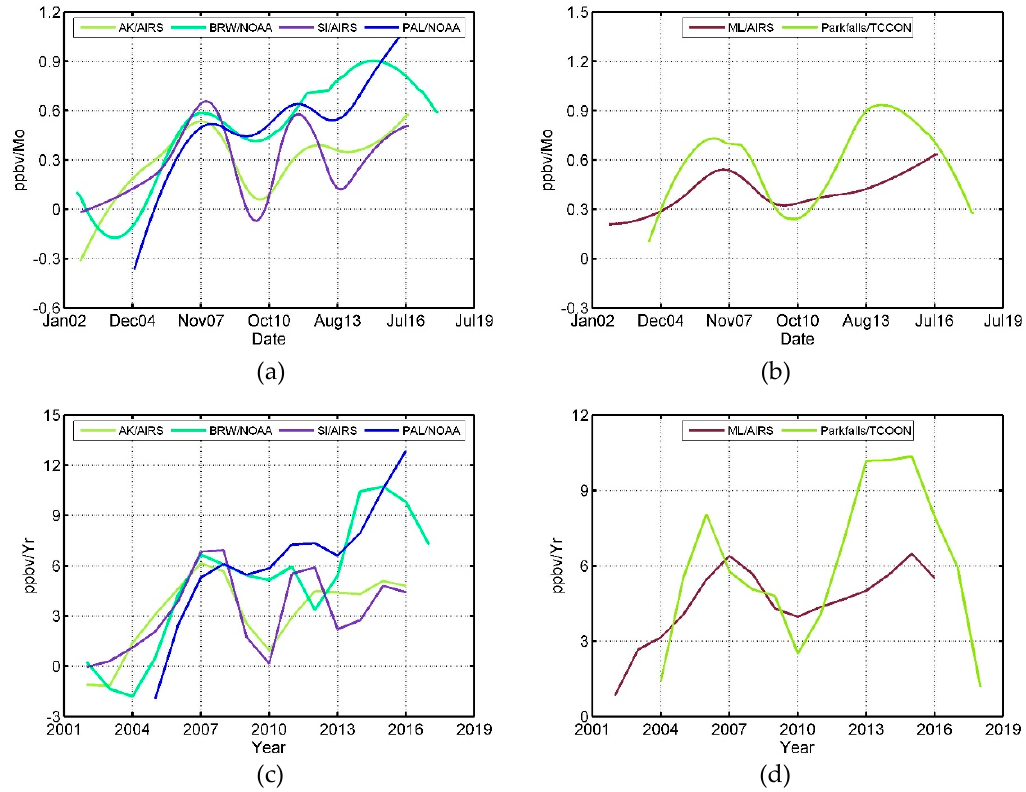
Figure 5. Comparisons of monthly and annual CH 4 increase rates (ppbv per month, ppbv/Mo and ppbv per year, ppbv/Yr) in the Northern Hemisphere from AIRS, TCCON, and NOAA ground-based measurements. ( a ), ( c ) show monthly and annual AIRS CH4 increase rates at 400 hPa over Alaska and Siberia regions and also surface CH 4 increase rates from two NOAA ground stations located in these two regions, respectively; ( b ), ( d ) show monthly and AIRS CH 4 increase rates over the Mid-latitude region defined above and X CH4 increase rates from Parkfalls/TCCON.